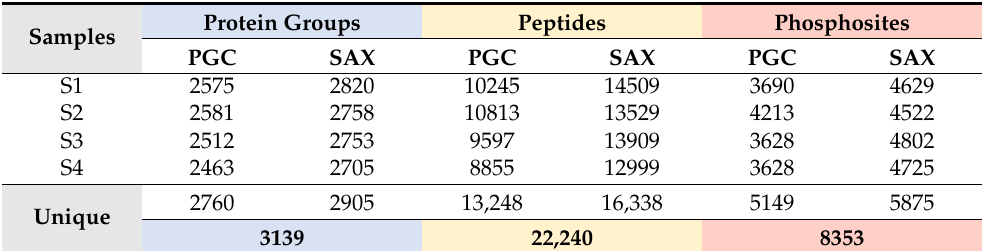
Table 1. Summary of the protein groups, peptides, and phosphosites identified in particular samples after Fe-IMAC phosphopeptide enrichment followed by PGC and SAX fractionations.